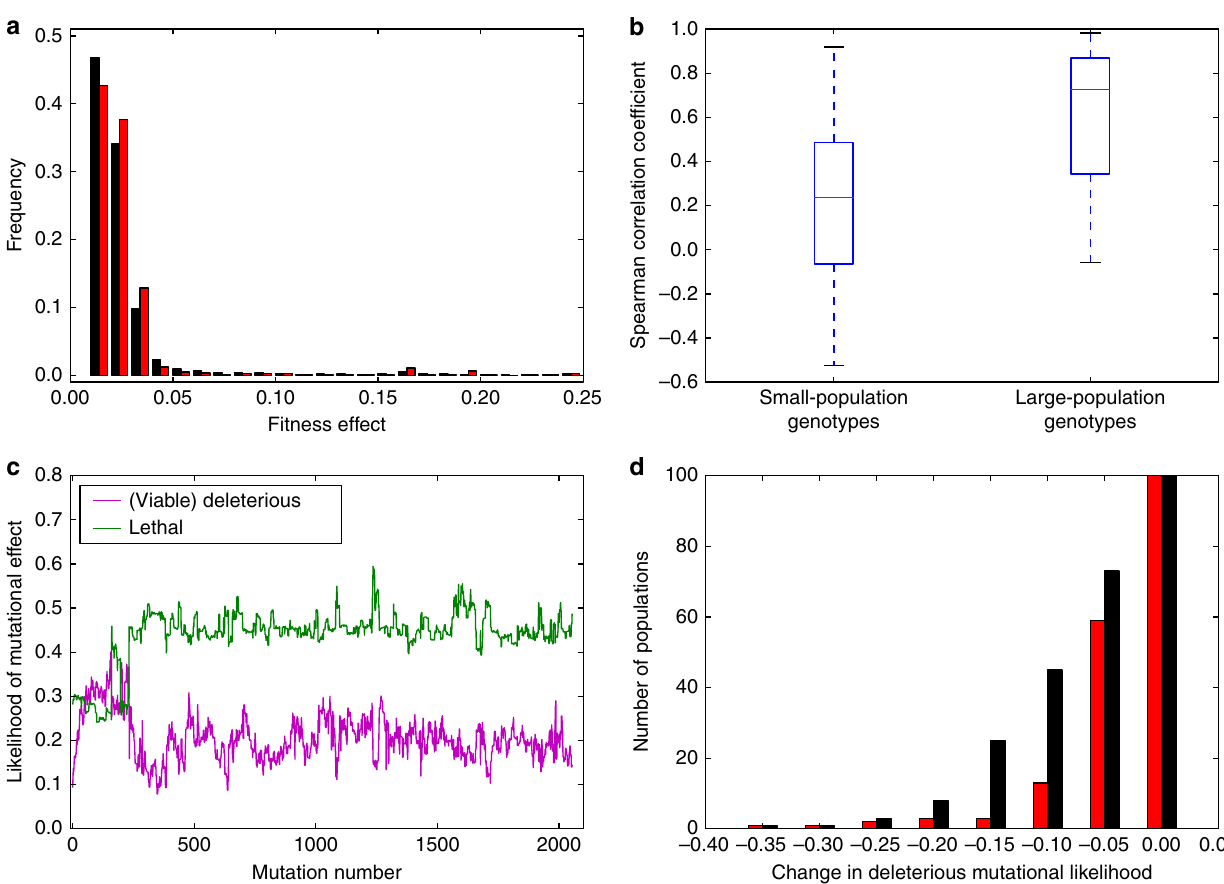
Fig. 7 Evidence of small-population adaptation to drift-robust fi tness peaks. a Distribution of maintained bene fi cial mutational effects for (effects for mutations whose fi tness gain was at-least partially maintained during subsequent evolution) small-population genotypes ( black ) and large-population genotypes ( red ). b Spearman correlation coef fi cients between fi tness and the likelihood of a deleterious mutation for each maintained bene fi cial mutation from each population c The likelihood of (viable) deleterious and lethal mutations, shown in magenta and green, respectively, in a representative small population ’ s lineage. The strong decrease in the likelihood of a (viable) deleterious mutation early in the population ’ s history is evidence of epistatic mutations resulting in drift robustness. d Number of populations that fi xed a maintained bene fi cial mutation that decreased the likelihood of a (viable) deleterious mutation by at least a speci fi ed amount. Colors as in